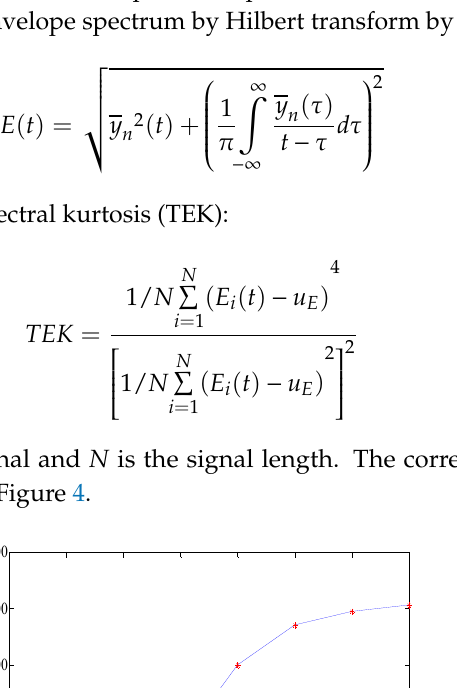
Figure 4. The Teager envelope spectral kurtosis (TEK) values for different SNRs.